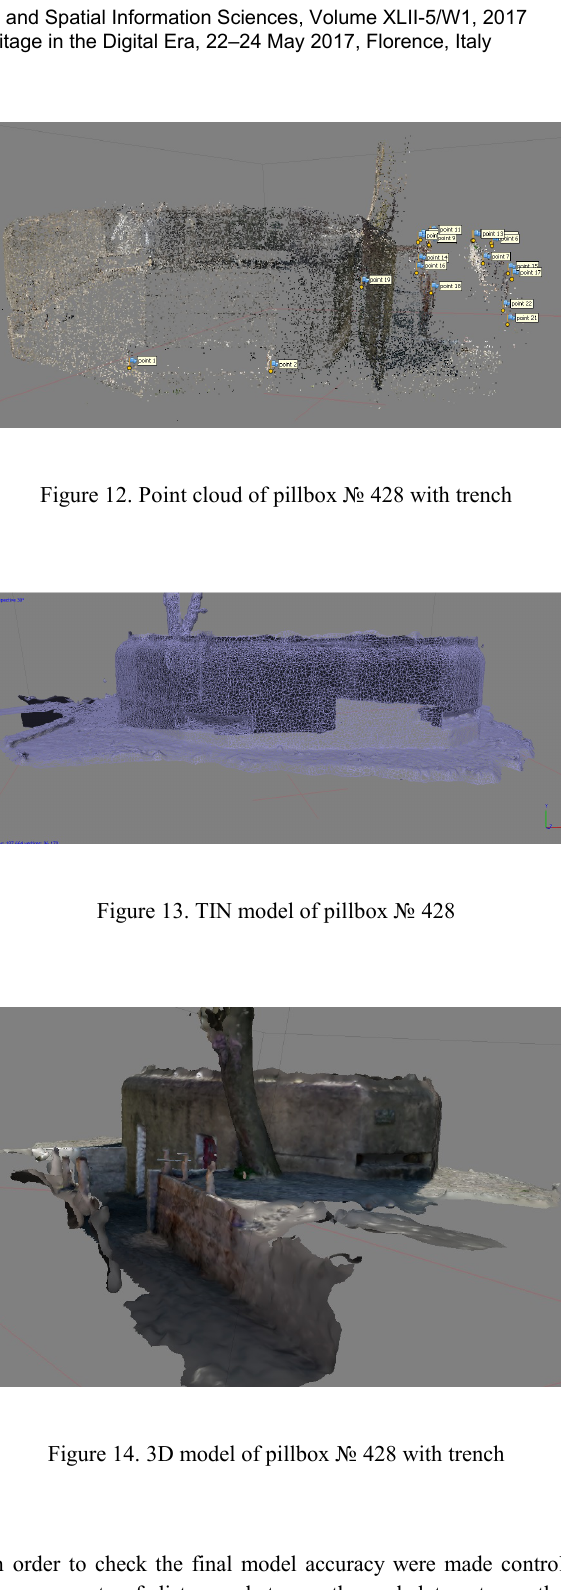
Figure 11. Camera geometry for pillbox № 428